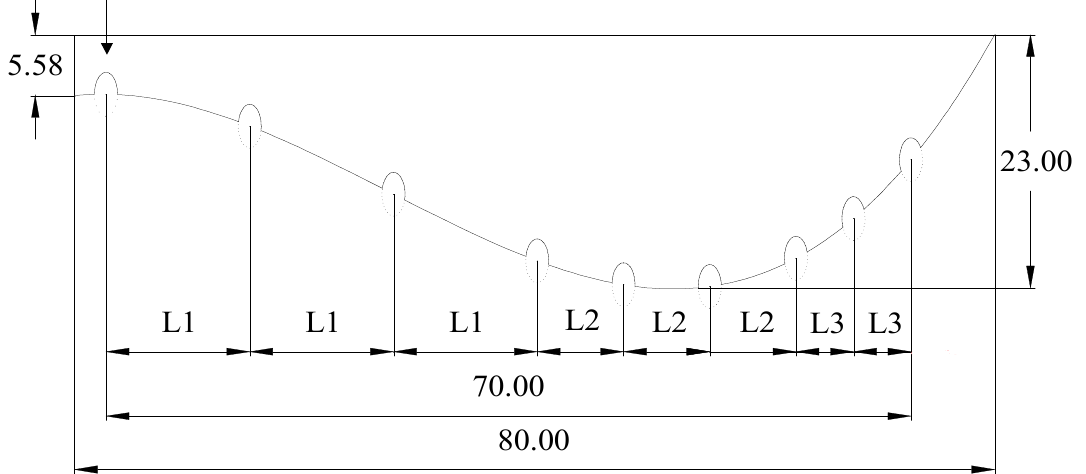
Figure 4. Structure schematic diagram of biomimetic goat hoof shoe with grooves.